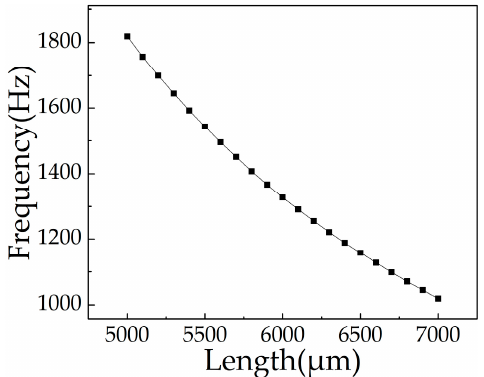
Figure 2. The ANSYS simulation curve between resonance frequency and length of cantilever beam.